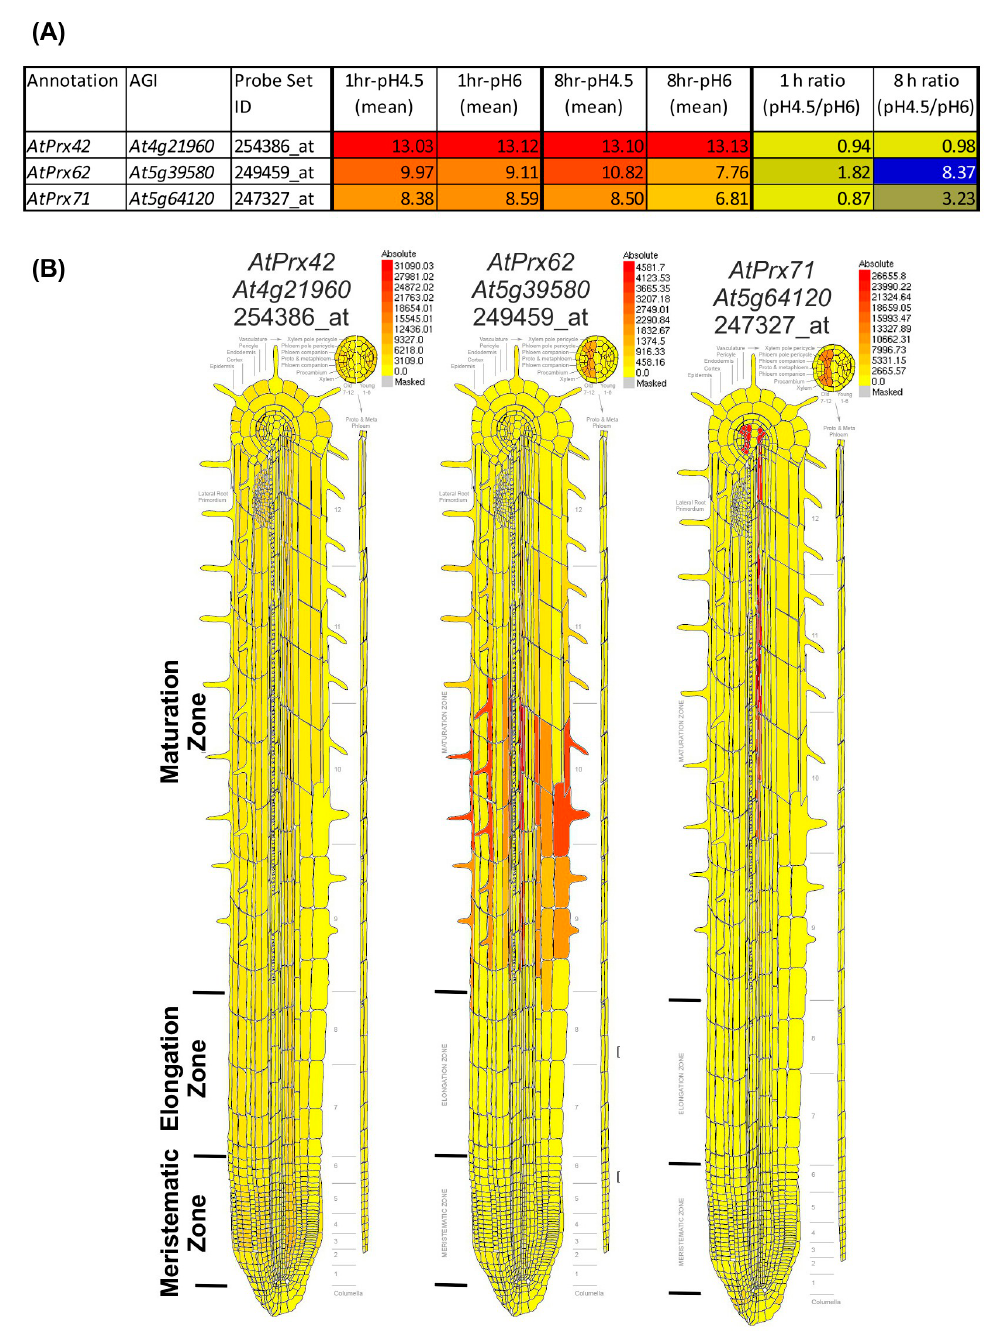
Figure 2. Transcriptomic data mining enables selecting AtPrx62 and AtPrx71 CIII Prx candidate genes for involvement in low pH response, and AtPrx42 as a control gene. ( A ) NASC 470 low pH transcriptomic data [18] was downloaded and edited. The mean of the log2(expression values) for each condition ( n = 3) was calculated as well as the ratio of absolute expression for low pH versus control pH. The 73 CIII Prxs [37] were searched within the transcriptomic data. An absolute heat map was drawn for the expression values (red to yellow to grey) with an arbitrary threshold value set as